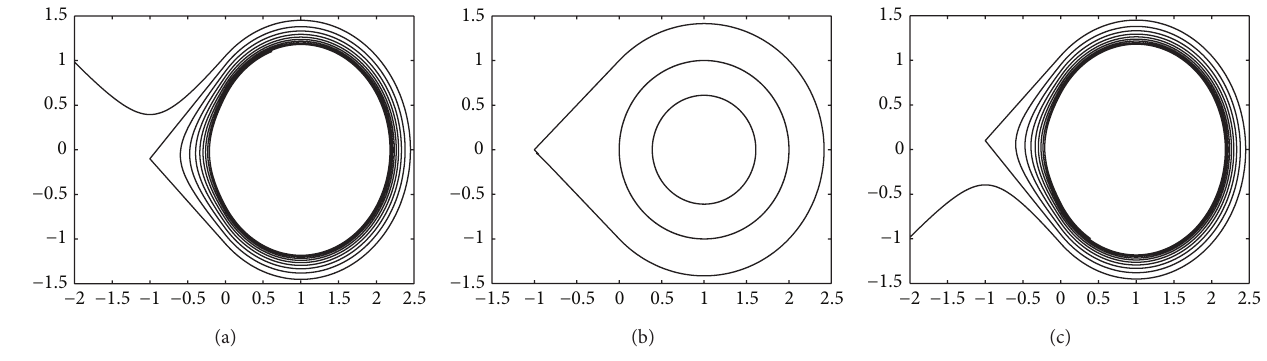
Figure 7: : Bifurcation of saddle-center